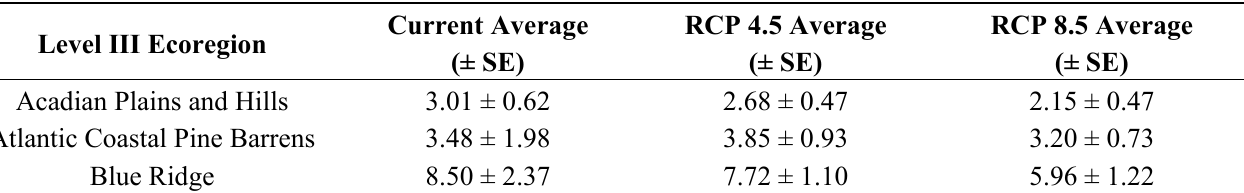
Figure 1. Study site extent in the northeastern U.S. depicting EPA Level III ecoregions and the North Atlantic Landscape Conservation Cooperative (NALCC) Boundary (area within red boundary). This figure should be used to reference Tables 1 and 2. Table 1. Mean climate refugia richness ( i.e. , number of salamander species with a climatically-suitable niche in a landscape patch) within U.S. EPA Level III Ecoregions in the northeastern U.S. (Figure 1) based on current and 2050 projected climatic conditions. Mean refugia richness was calculated for both current and projected scenarios among two Global Climate Models (CCSM4 (CCSM) and HadGEM2-CC (Hadley)) and two Representative Concentration Pathways (RCP 4.5 and